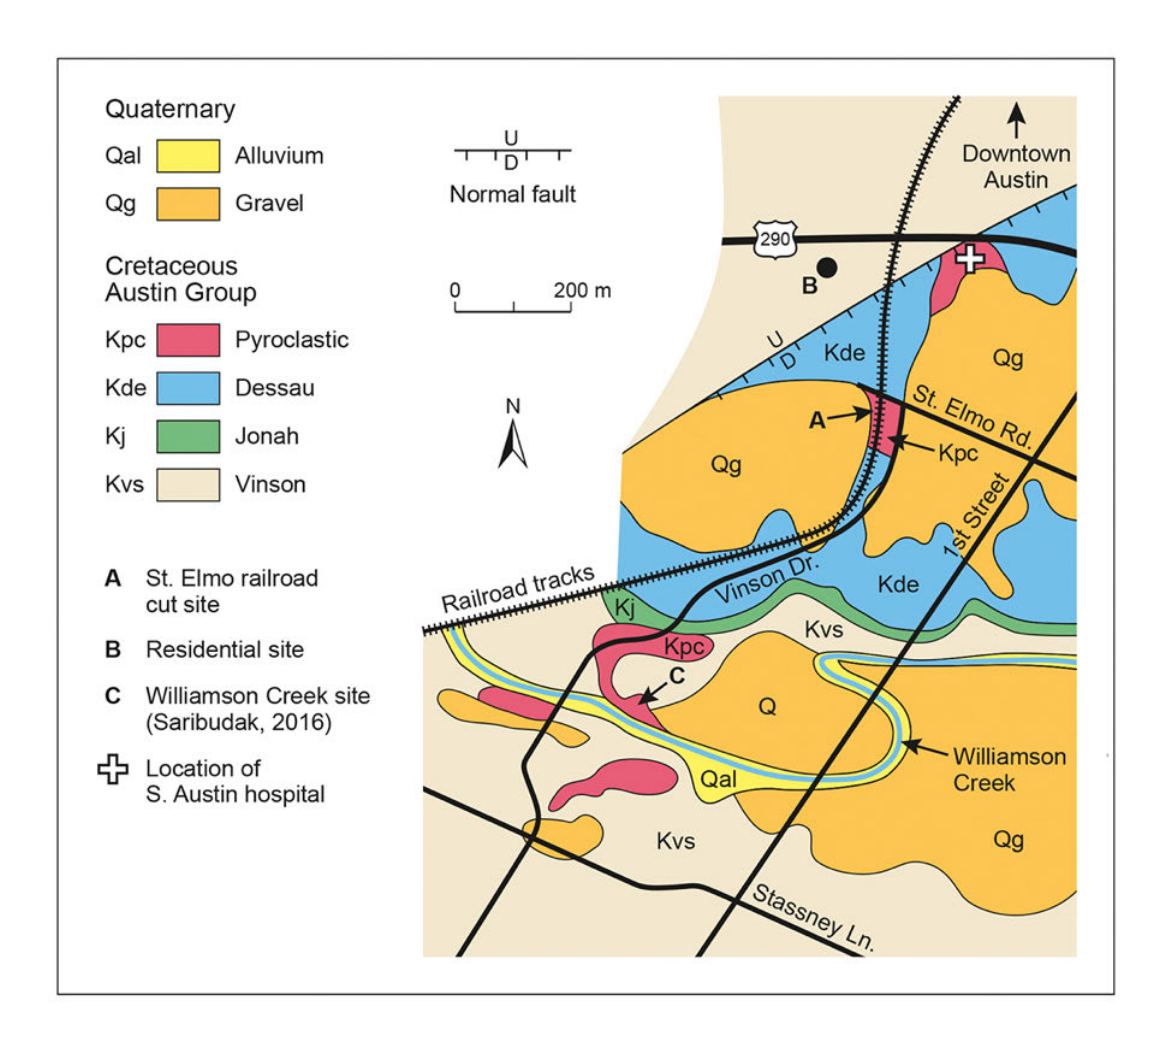
Figure 5: A geological map of the study and surrounding areas. The map is based on the original map published by Young et al. [1982]. Note that a significant fault of the BFZ is crossing south of the residential site ( B ). data to reduce